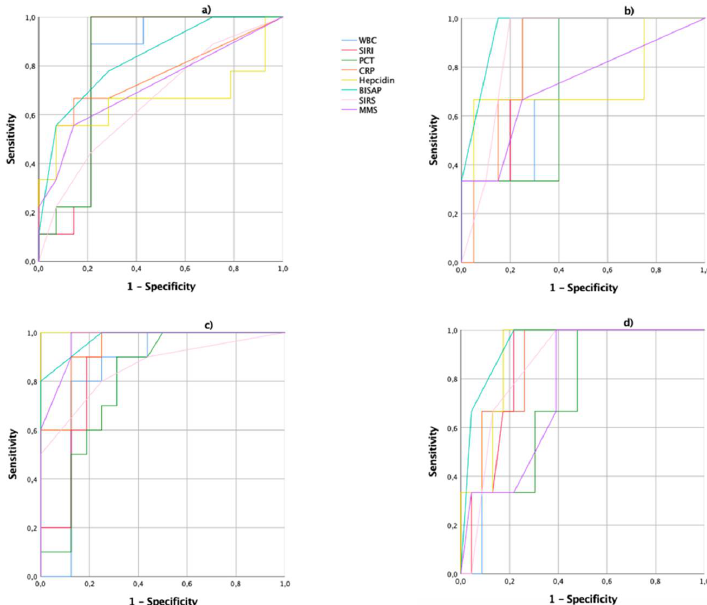
Figure 1. Receiver operating characteristics (ROC) curves for determining the cut-off values of WBC, SIRI, PCT, CRP, hepcidin, BISAP, SIRS, and MMS of ( a ) severe AP and ( b ) mortality on admission and ( c ) severe AP and ( d ) mortality 48 h after onset of symptoms. AP: acute pancreatitis; BISAP: bedside index for severity in acute pancreatitis; BMI: body mass index; CRP: C-reactive protein; MMS: modified Marshall score; SIRS: systemic inflammatory response syndrome; WBC: white blood cells.